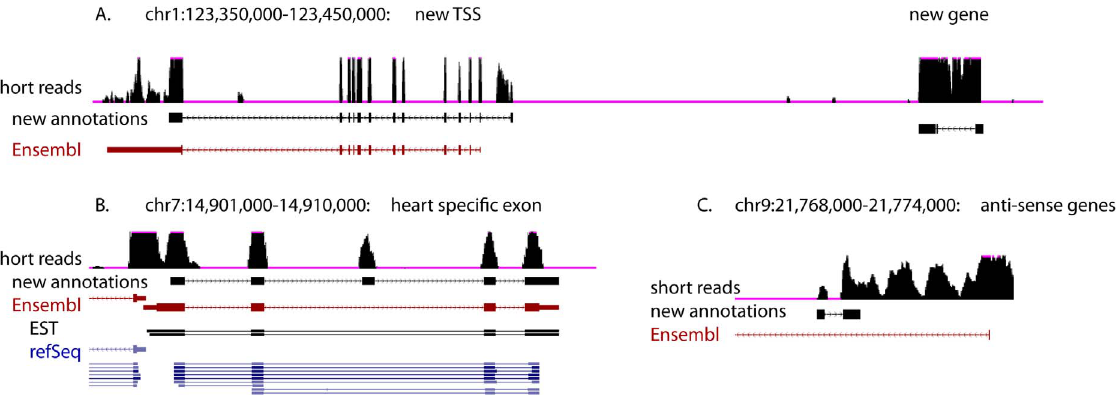
Figure 4. Identification of new isoforms and genes. Shown in this image from the UCSC genome browser are examples of the new genes and isoforms identified from among the short and long-read annotations: A. This region carries two distinct annotations, one for an alternate transcription start site (TSS), and another for a completely new gene that is currently unannotated. B. A heart-specific isoform of the FKBP7 gene. C. Both long-read and short-read data support the existence of transcripts going in opposite directions in this region of chromosome 9.